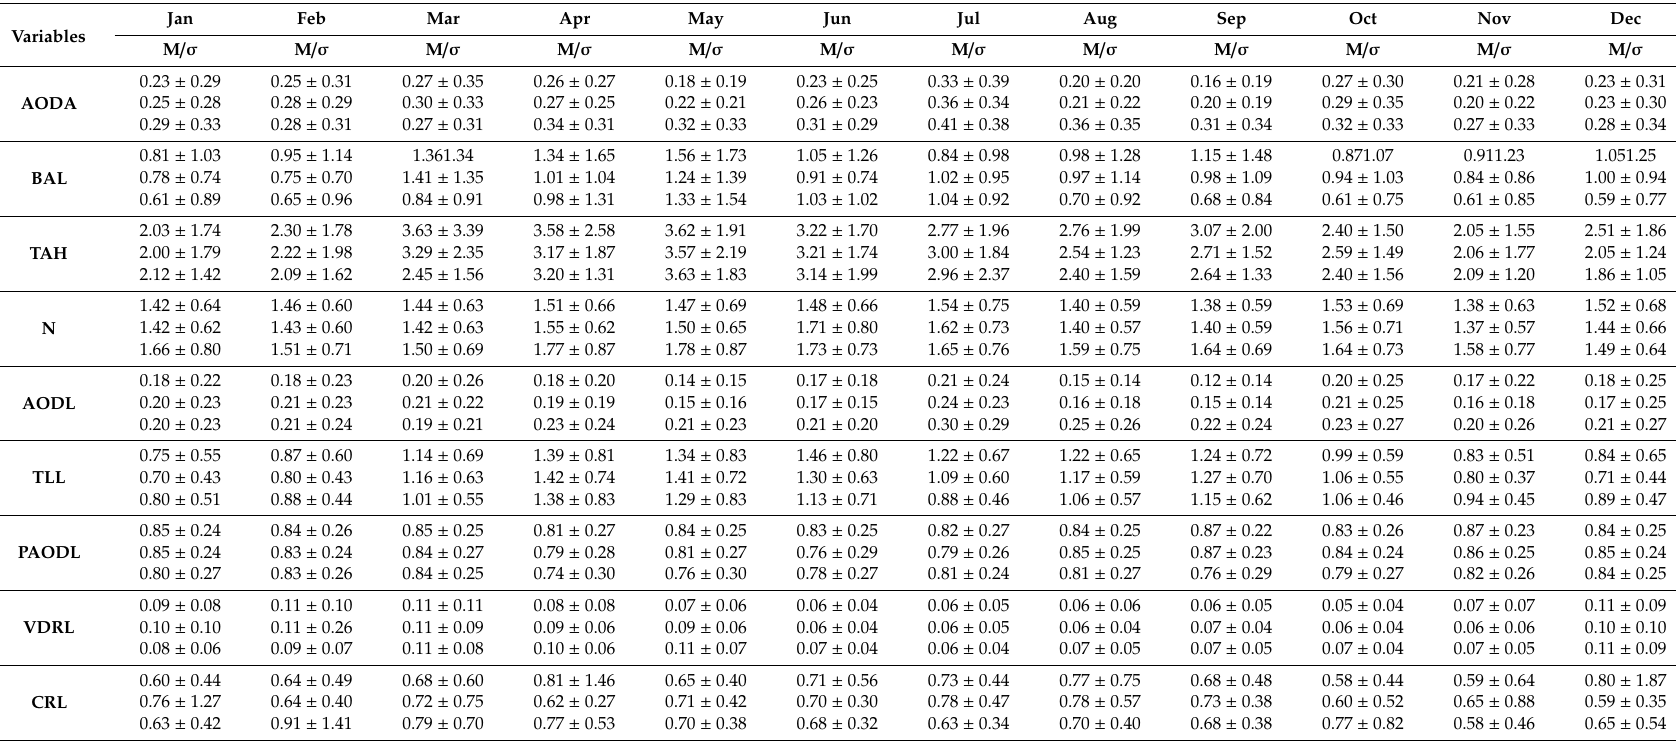
Table 3. Monthly mean and standard deviation values of nine variables in the daytime over NEC (HLJ, JL, and LN). For each variable, the top row is the value over HLJ, the middle row is the value over JL, and the bottom row is the value over LN.